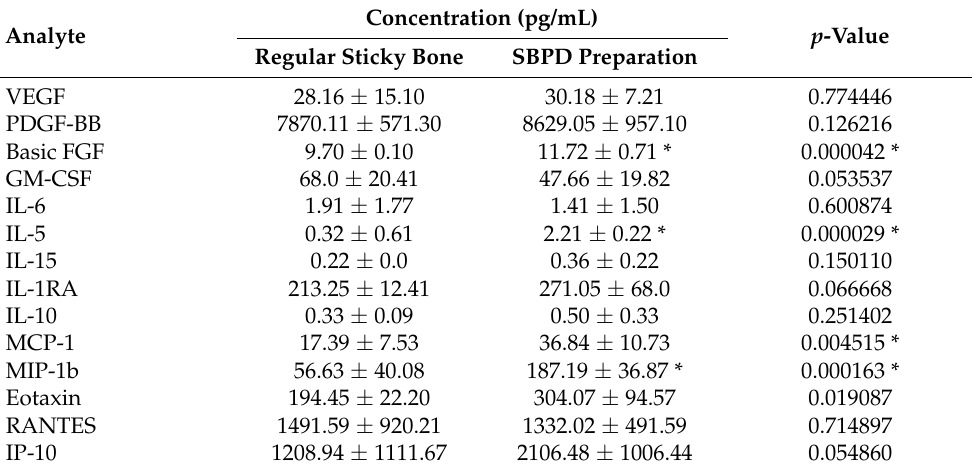
Table 1. Content of released growth factors and inflammatory mediators by sticky bone preparations produced with the SBPD ® , after 7 days of immersion in culture medium. Results indicate the mean ± SD of three biological replicates with three technical replicates. An asterisk indicates a significant difference between groups ( p <